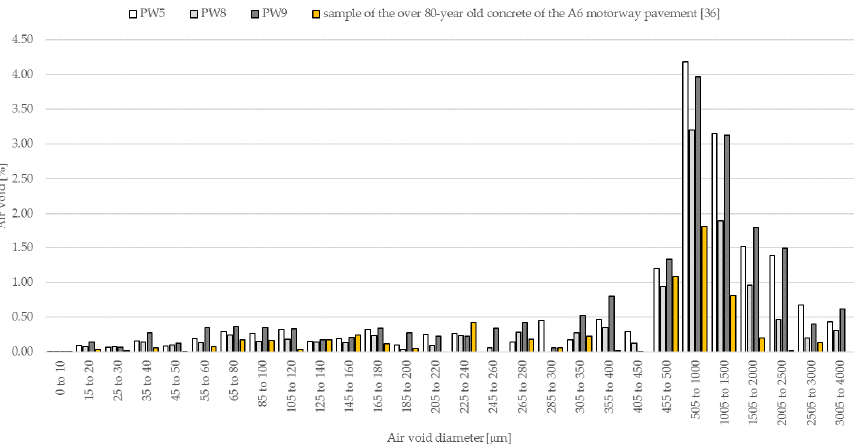
Figure 8. The distribution of air void diameters in the analysed concrete and sample of the over 80 year-old concrete of the A6 motorway pavement [36].